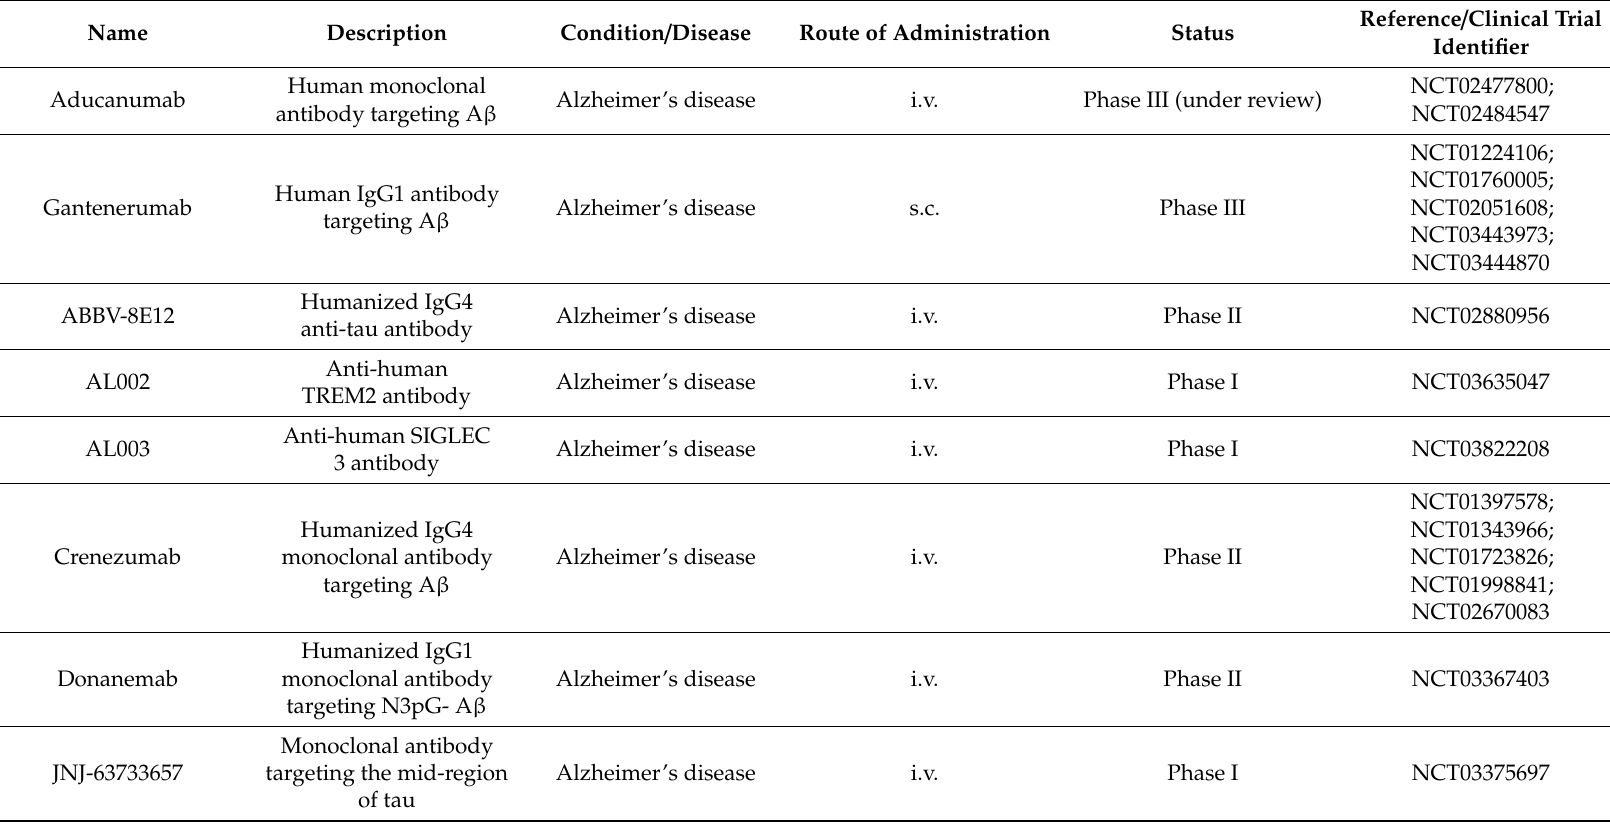
Table 3. Peptide / protein-based therapies in clinical trials for neurological